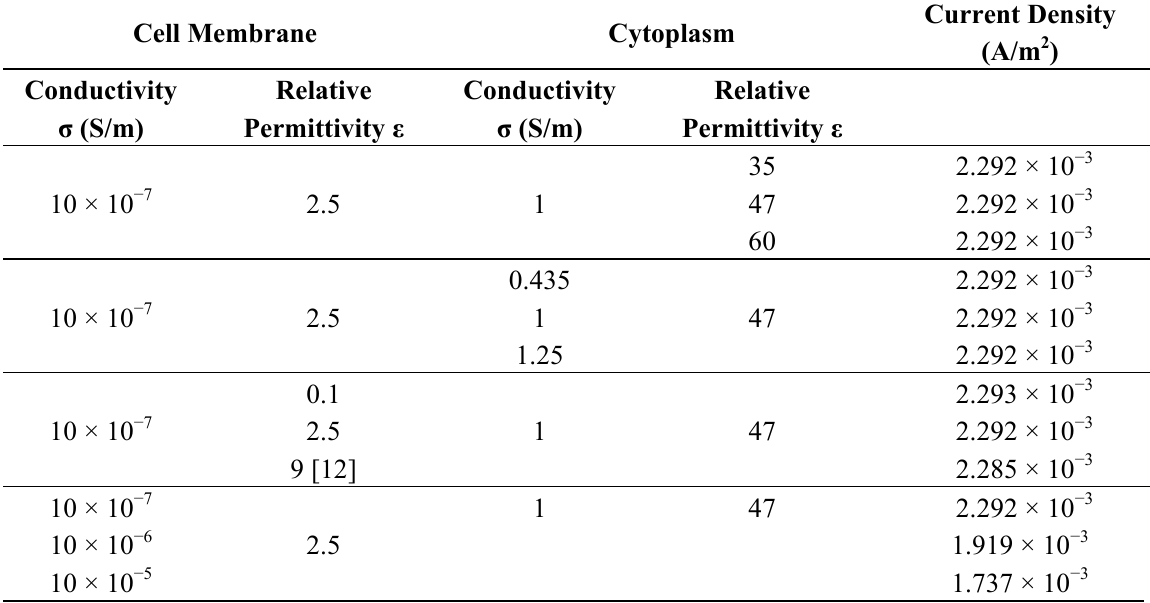
Table 2. Parametric studies for simulation of cell impedance.